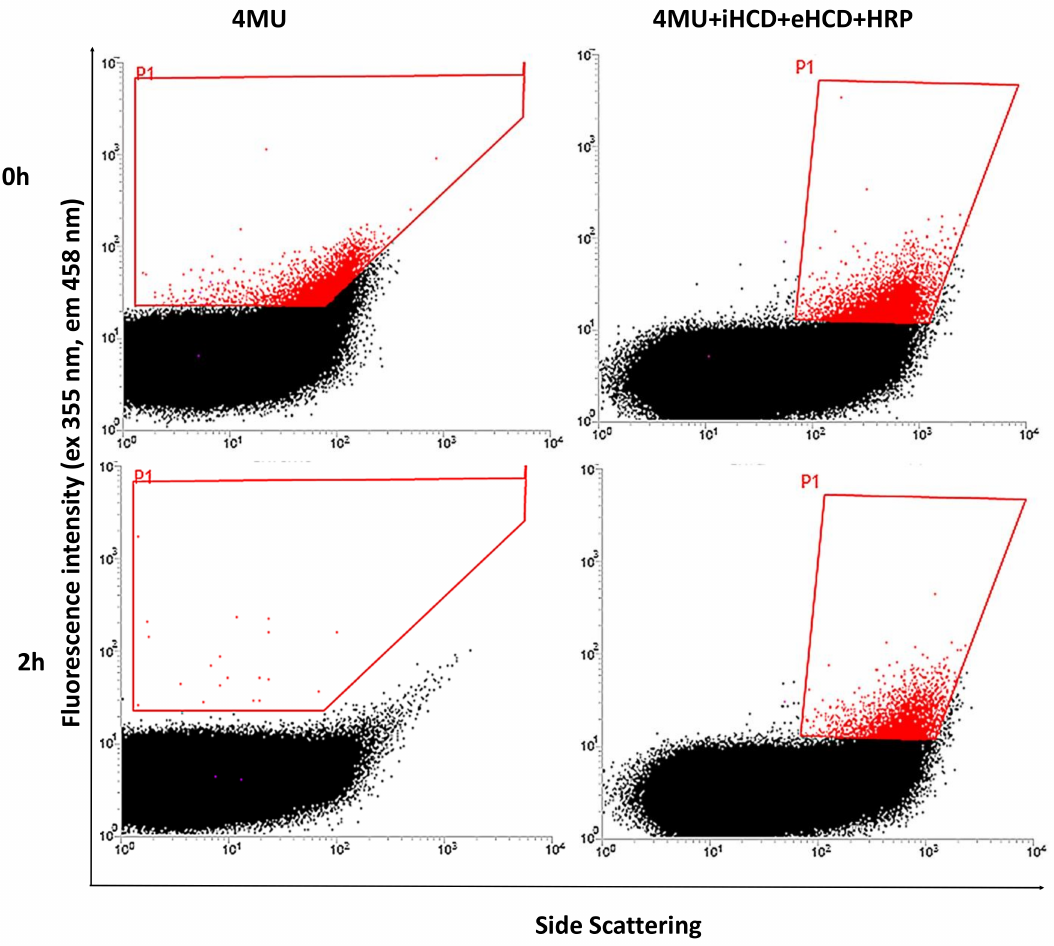
Figure 3. FACS analysis of 4-methylumbelliferone (4MU), 4MU+HCD in the internal phase (iHCD) and external phase (eHCD)+HRP, in double water-oil-water emulsions, after reaction for 2